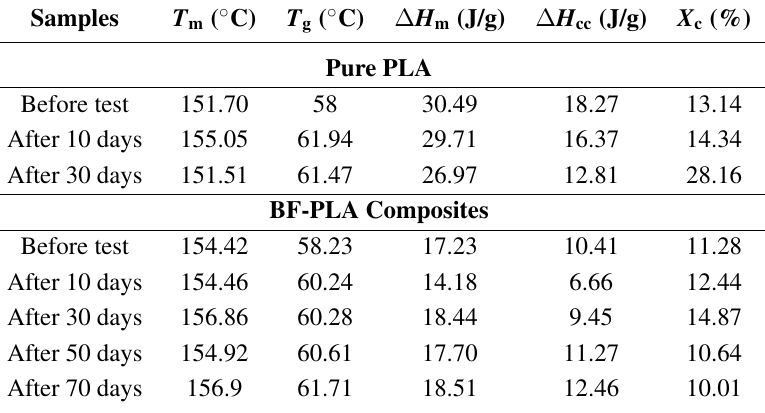
DSC numerical data of BF-PLA composites after biodegradation in real composting conditions.